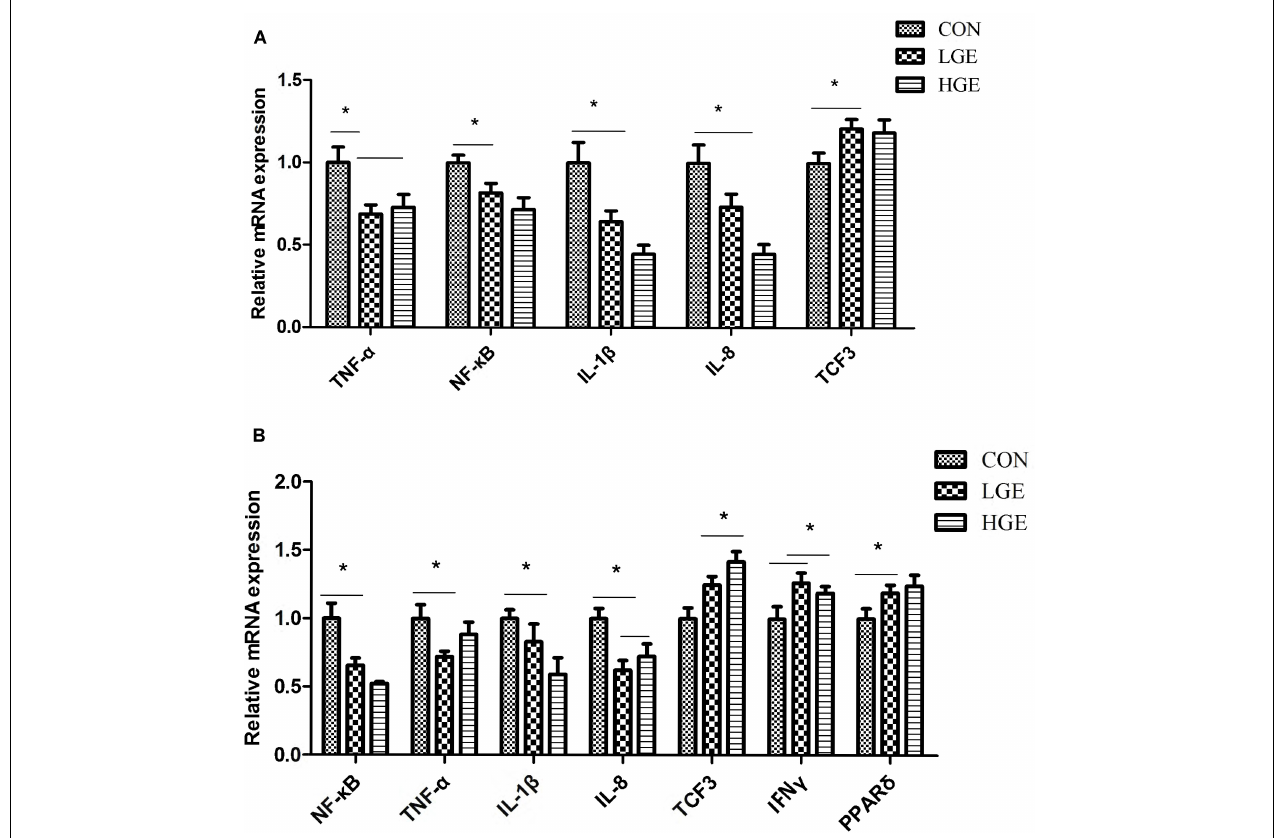
FIGURE 5 | (A,B) Represent the effect of GEN supplementation on the relative mRNA expression of genes related to the inflammatory reaction in the liver and spleen, respectively, n = 8 replicates. Data represent the mean ± SEM of the values. Means with ∗ are significantly